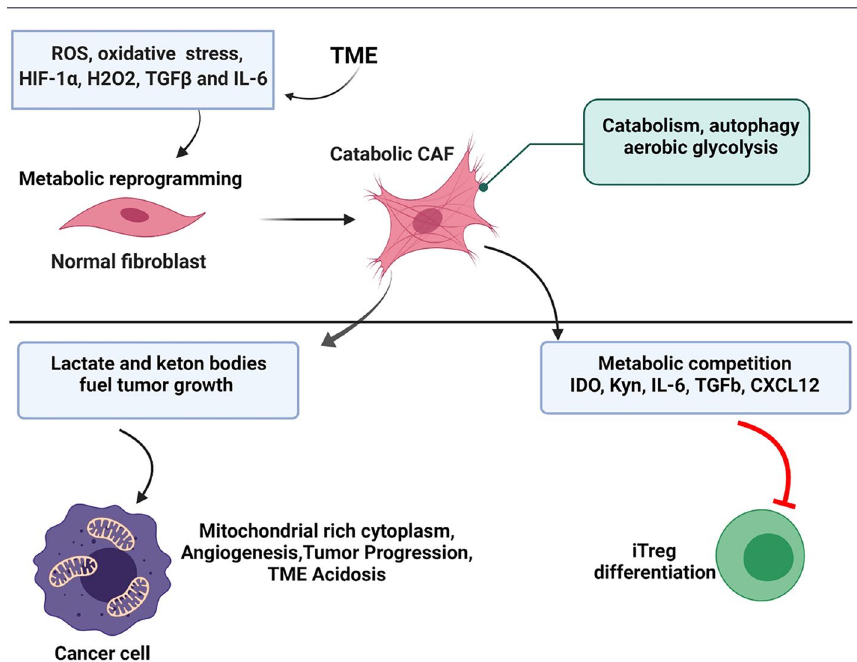
Fig. 1 Effects of CAF differentiation in the TME. Toxic TME drives metabolic reprogramming in the normal fibroblast towards the catabolic CAF. These cells are highly glycolytic, providing lactate and ketone bodies to fuel tumor growth and progression. The aberrant secretome of CAFs (also referred to as “cancer cell secretome”) contributes to metabolic stress in the TME and also inhibits the function of effector T cells and enables iTreg differentiation. CXCL12 C-X-C motif chemokine 12, IDO indoleamine 2,3-dioxygenase, IL interleukin, iTreg induced regulatory T cells, TGF transforming growth factor, TME tumor microenvironment; for other abbreviations, see Abbreviation section